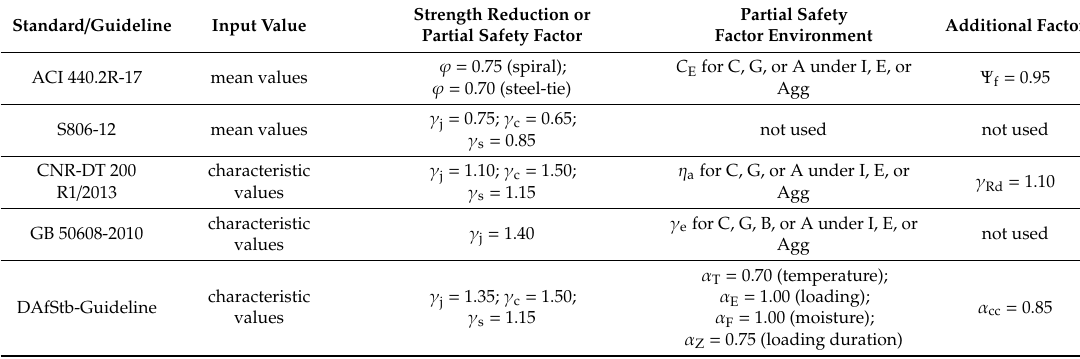
Table 3. Strength reduction and material safety